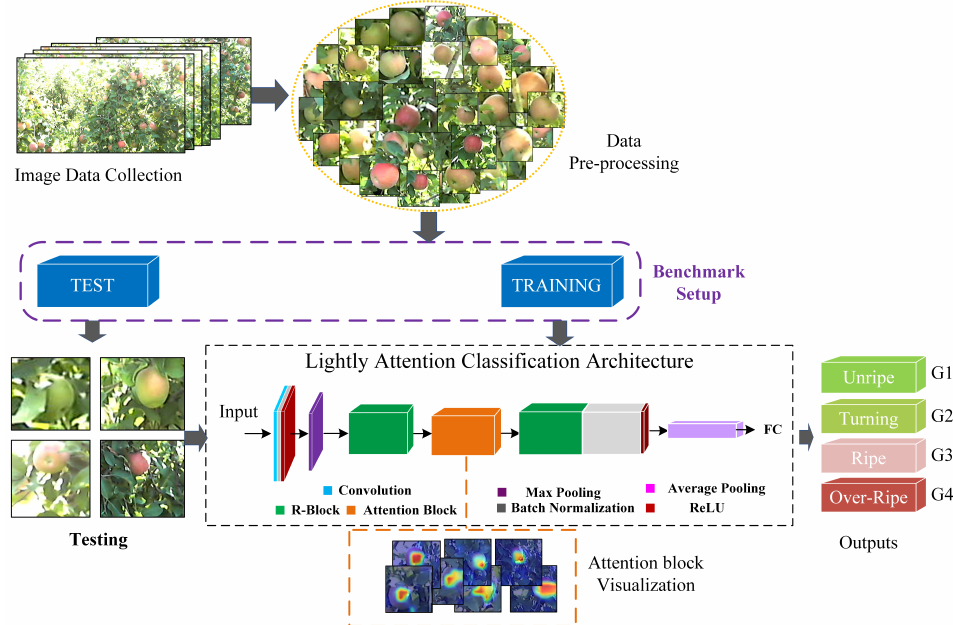
Figure 1. The overall flowchart of our Fuji apple maturity classification